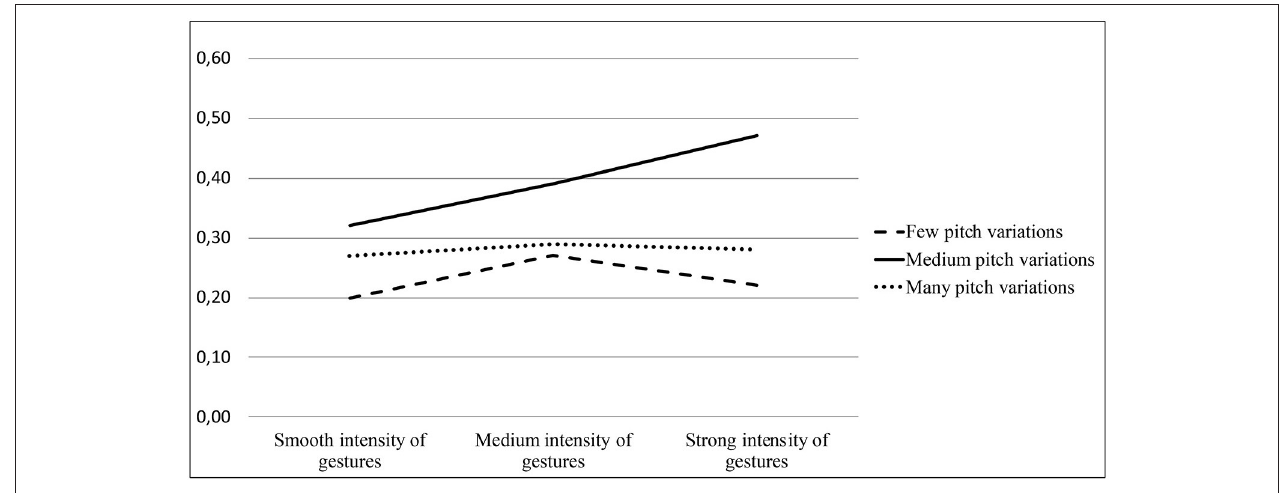
FIGURE 3 | EDA interaction voice pitch-hand